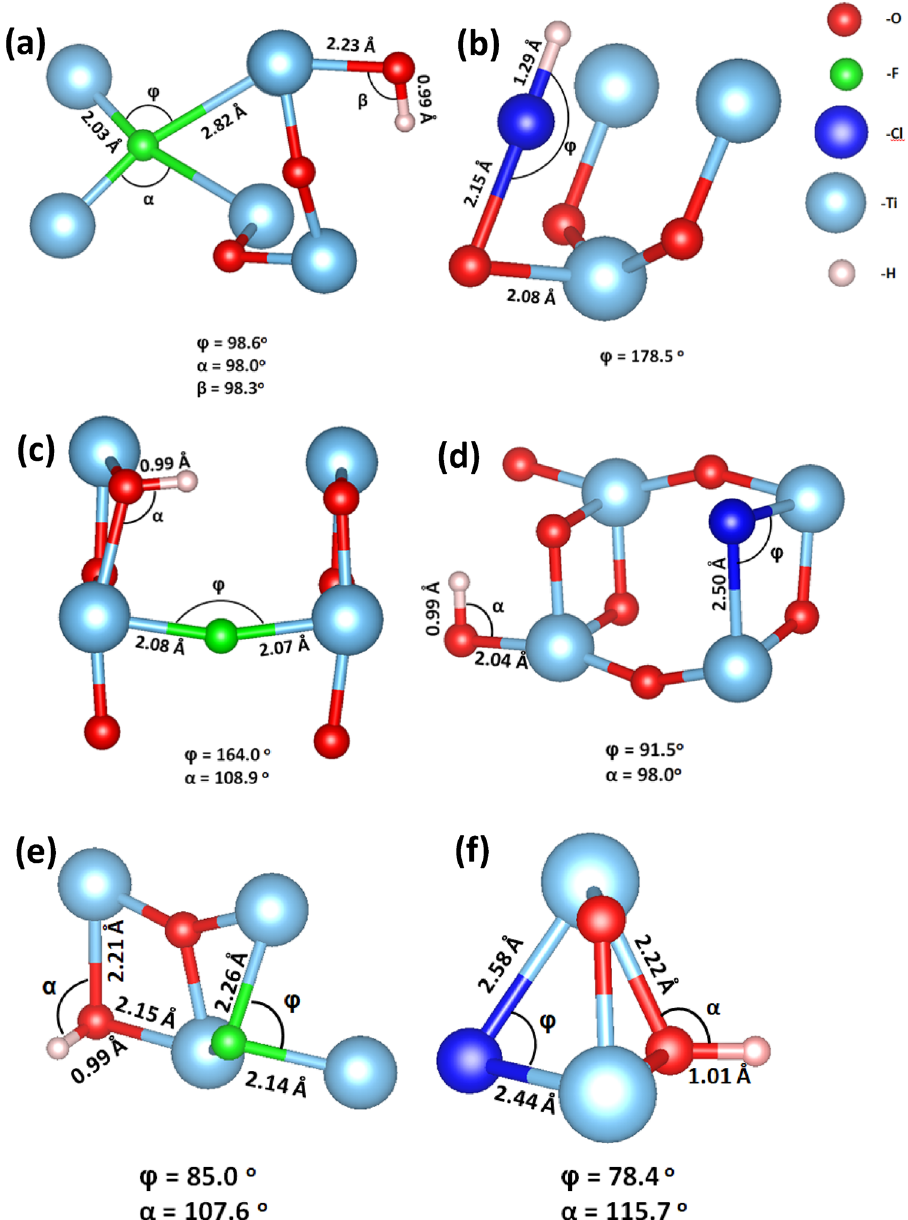
Figure 2. The structures, the angles and the distances of ( a ) F i :H i :TiO 2 , ( b ) Cl i :H i :TiO 2 , ( c ) F o :H i :TiO 2 and ( d )